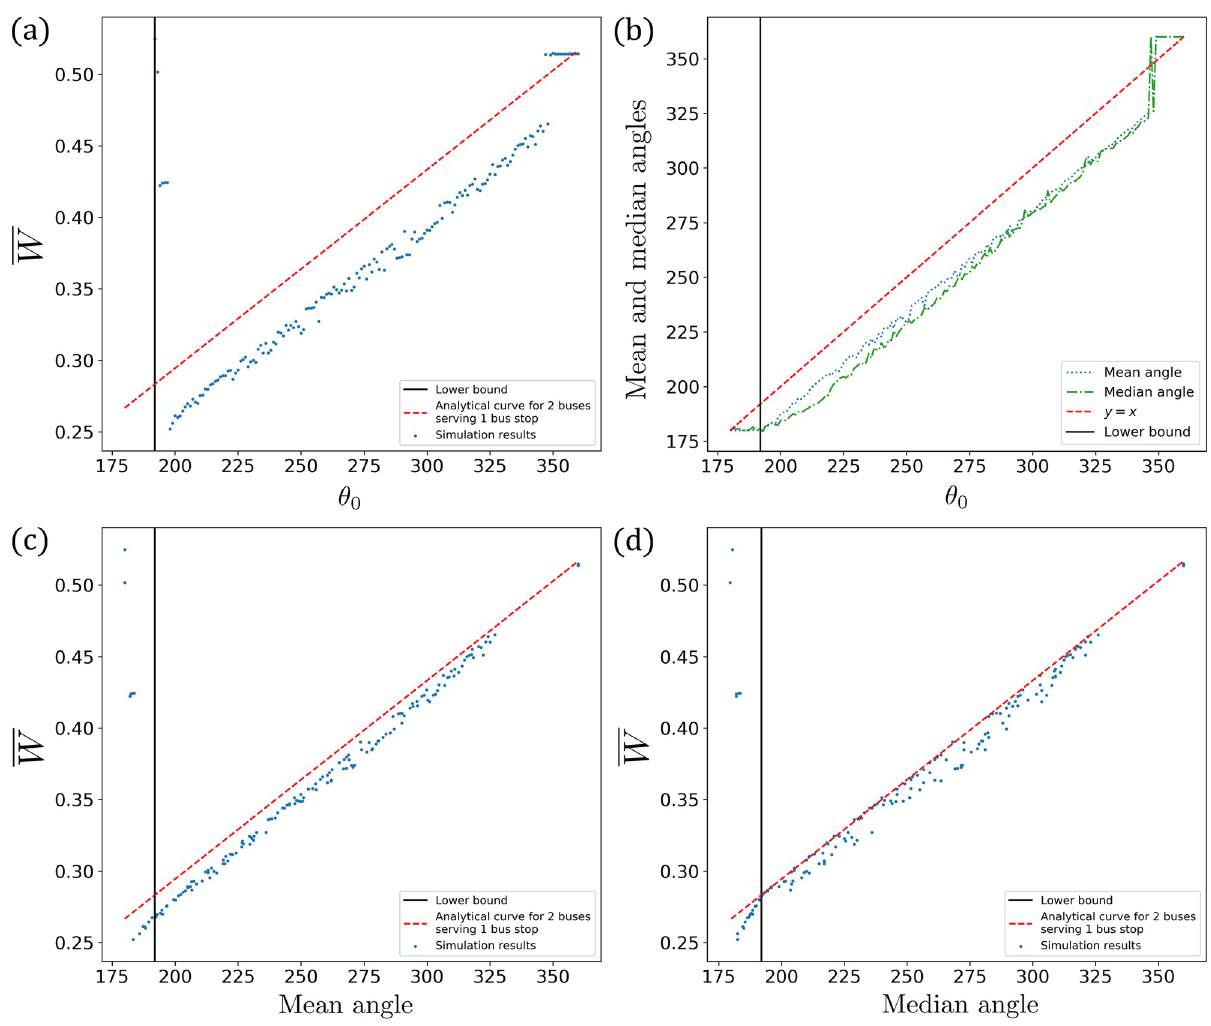
Fig 4. Graphs of � W versus: (a) θ 0 , (c) the mean, as well as (d) median phase differences, respectively. The effective phase difference θ eff during steady state being the median phase difference between the two buses more closely matches the predicted value from Eq (15), compared to the mean phase difference. Note that below the lower bound θ 0 = θ min , � W blows up by two orders of magnitude (not plotted): � W ¼ 10 : 4 at θ 0 = 191˚, � W ¼ 31 : 5 at θ 0 = 190˚, � W ¼ 54 : 6 at θ 0 = 189˚, ... . Similar graphs can be obtained for any value of k . (b) The relationship between θ 0 and the mean as well as median phase differences as measured from the